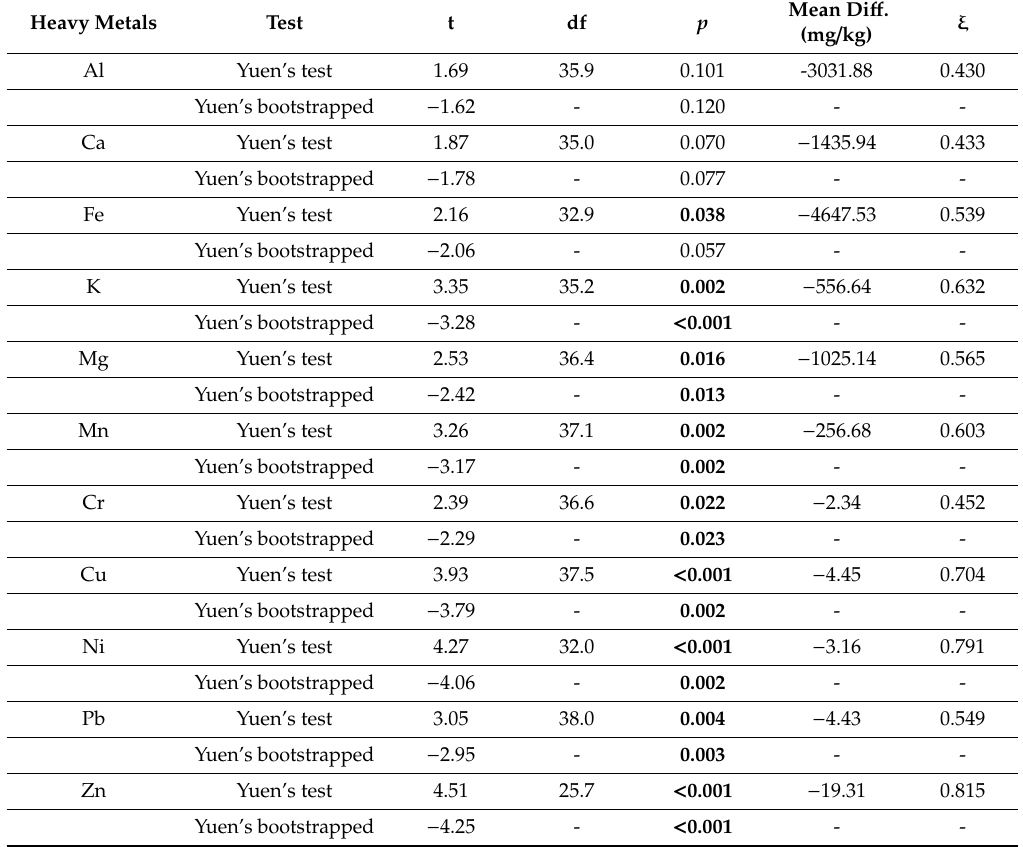
Table 2. Di ff erences of heavy metals by point bars and swales according to the Robust Independent Samples (Yuen’s) T -Test (t: t-statistic, df: degree of freedom, p : significance, mean di ff .: mean di ff erence between heavy metal content, ξ : e ff ect size; p < 0.05 highlighted with